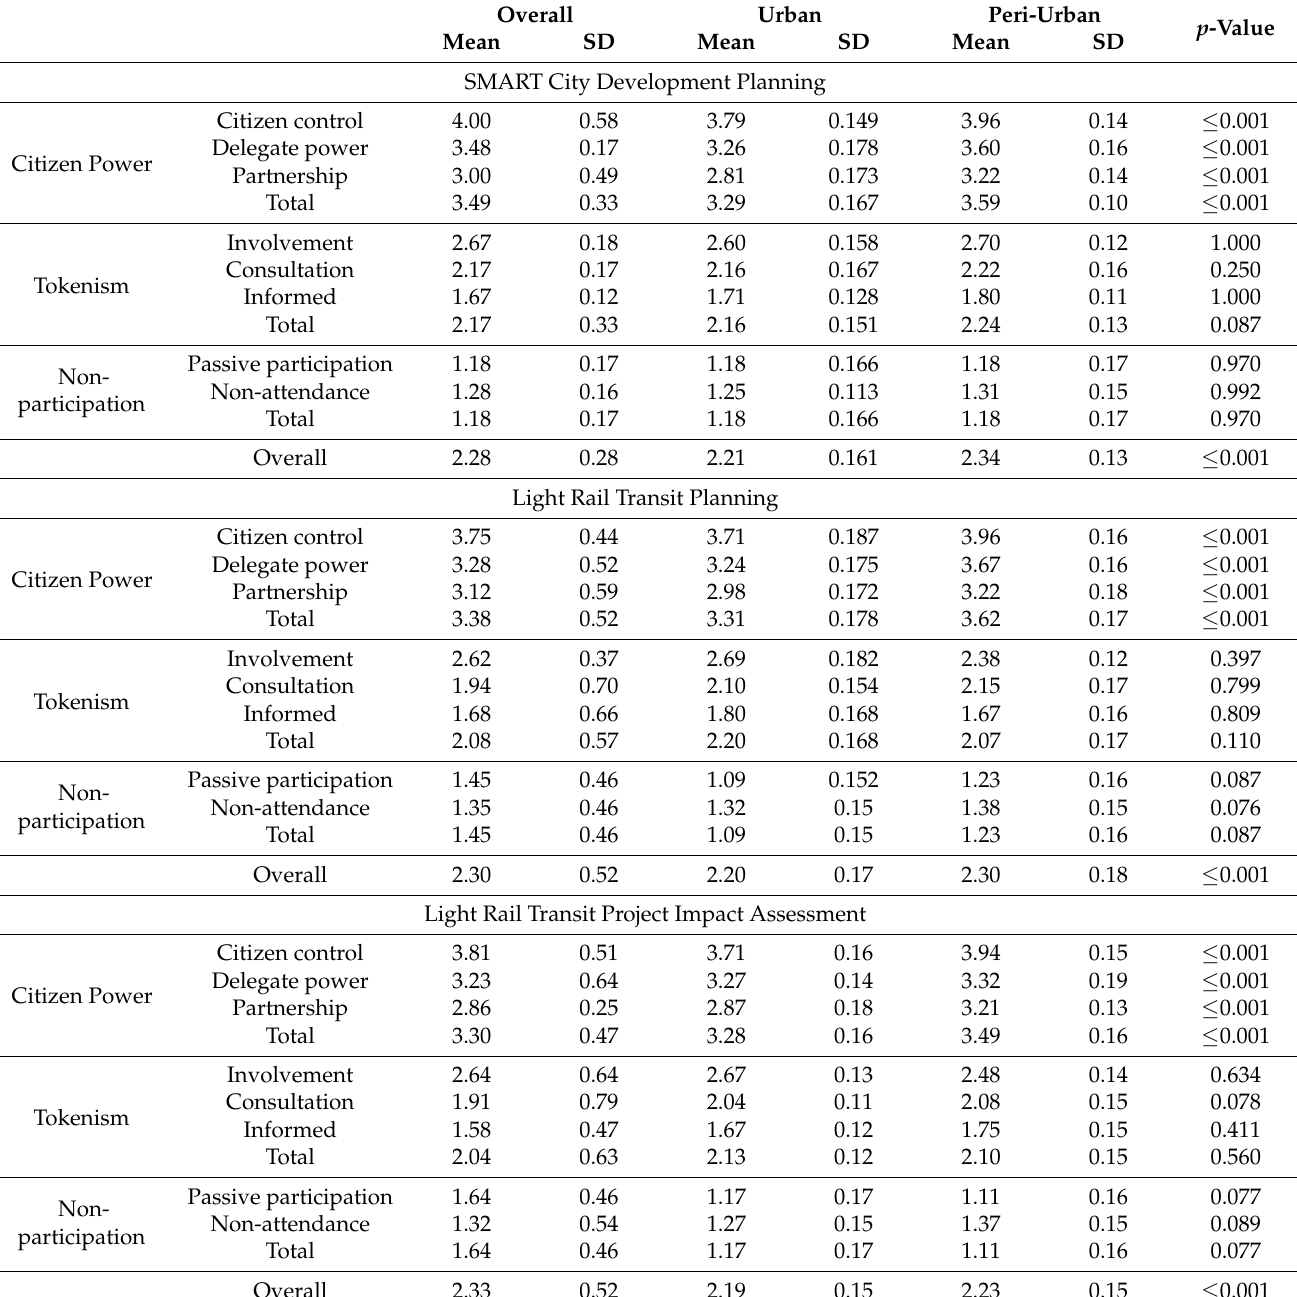
Table 3. The respondents’ patterns of public participation in urban and peri-urban areas ( n = 505). Overall Urban